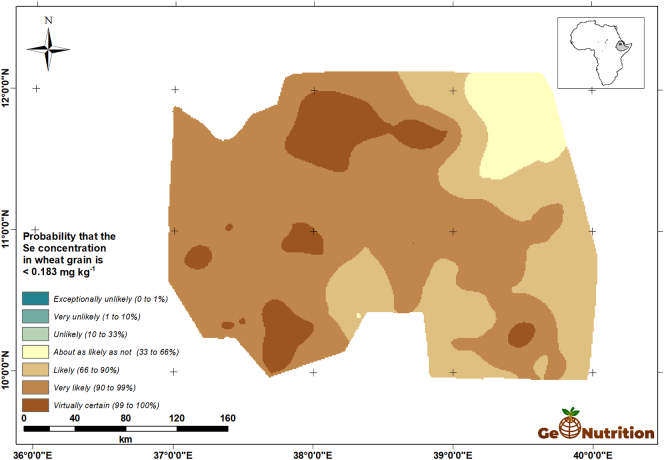
Probability that Se concentration in wheat grain <0.183 mg kg−1 using a verbal scale of calibrated phrases from Mastrandrea et al. (2010).